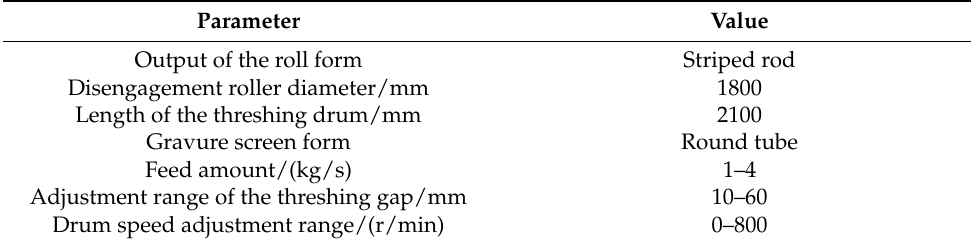
Table 1. Parameters of equipment used in the threshing test bench. Parameter